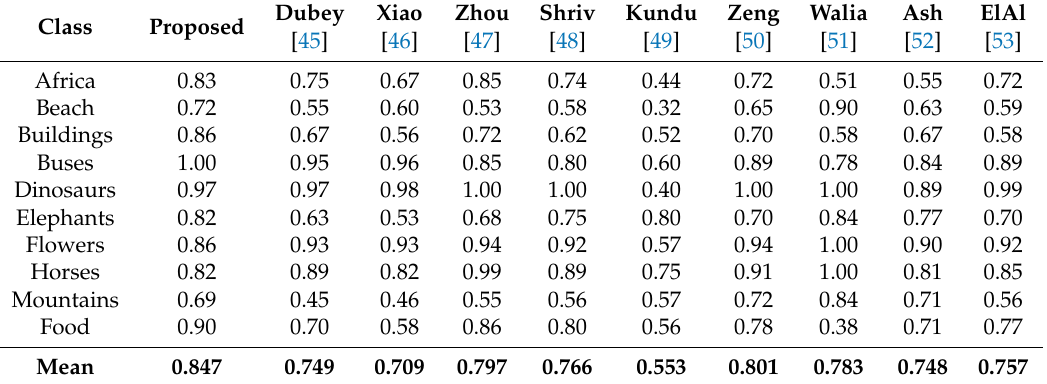
Table 2. Comparison of average precision obtained by proposed method and other standard retrieval systems on top 20 retrievals.